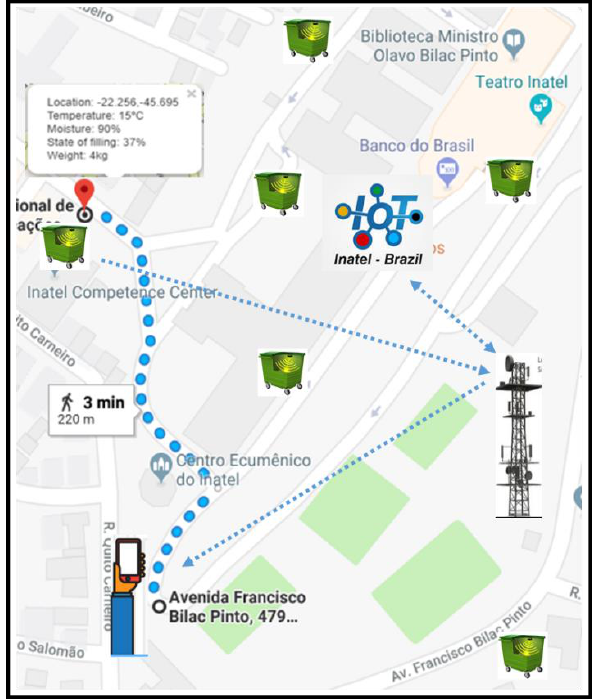
Figure 7. Available route presented by My Waste App.